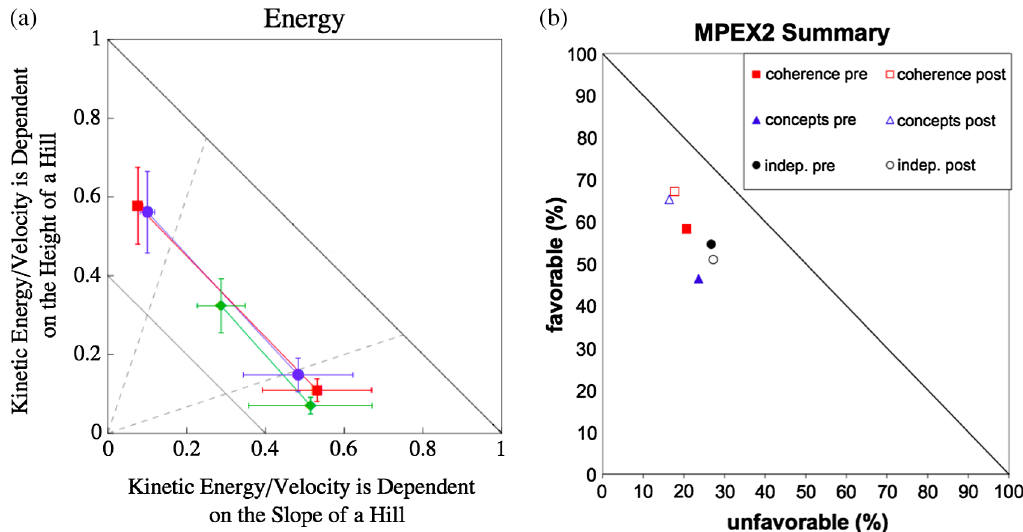
FIG. 3. Examples of 2D plots taken from research studies carried out by the authors. (a) Bao ’ s model analysis plots show two commonly used models on a single plot (see Ref. [7] for more details). (b) MPEX plots show the class percentage of favorable and unfavorable responses to questions (see Ref. [13] for more